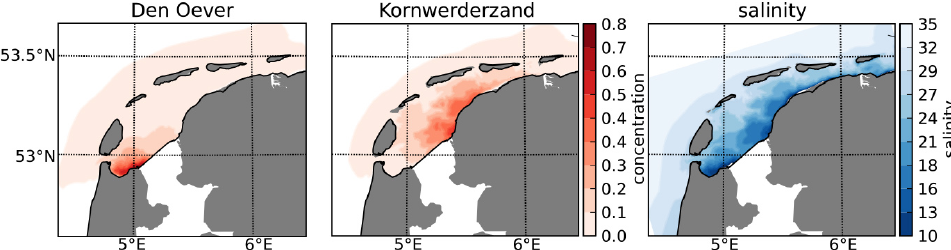
Figure 16. Average concentration in the uppermost layer of the passive tracer from (a) Den Oever and (b) Kornwerderzand for the month of April 2009. (c) Average salinity in the upper layer for the same month.